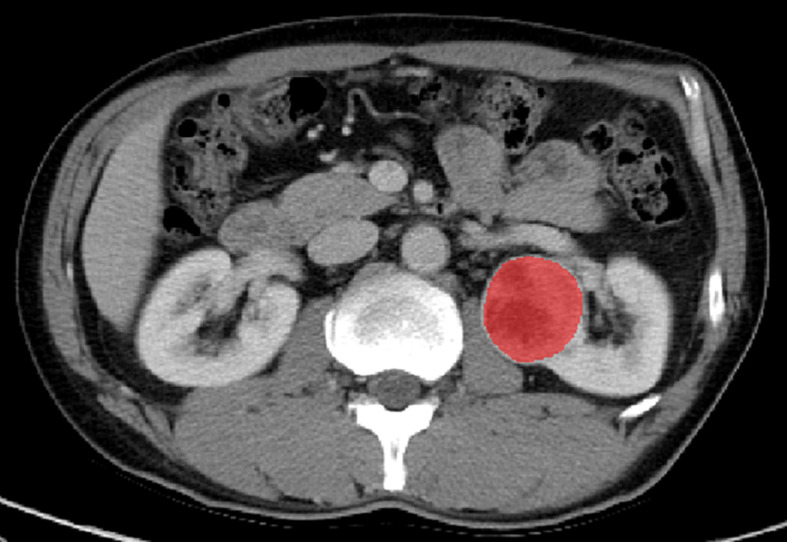
Manual segmentation of the tumor on the center axial slice of the clear cell renal cell carcinoma (ccRCC).